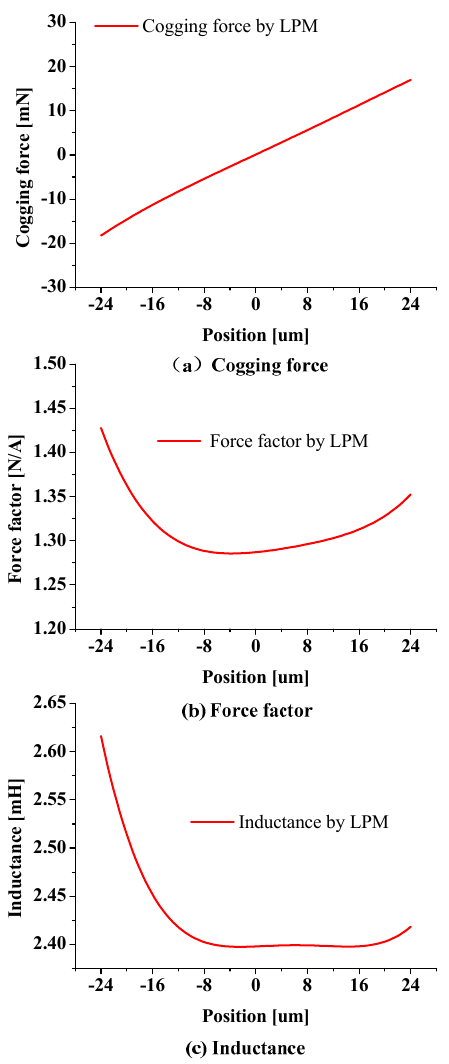
Figure 2. Electromagnetic parameters vs displacement.